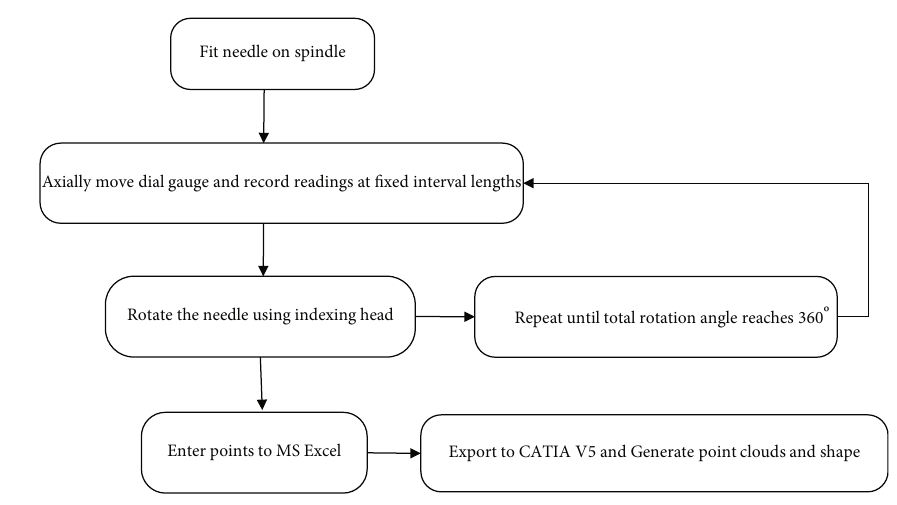
Figure 4: Methodology to record needle pro fi